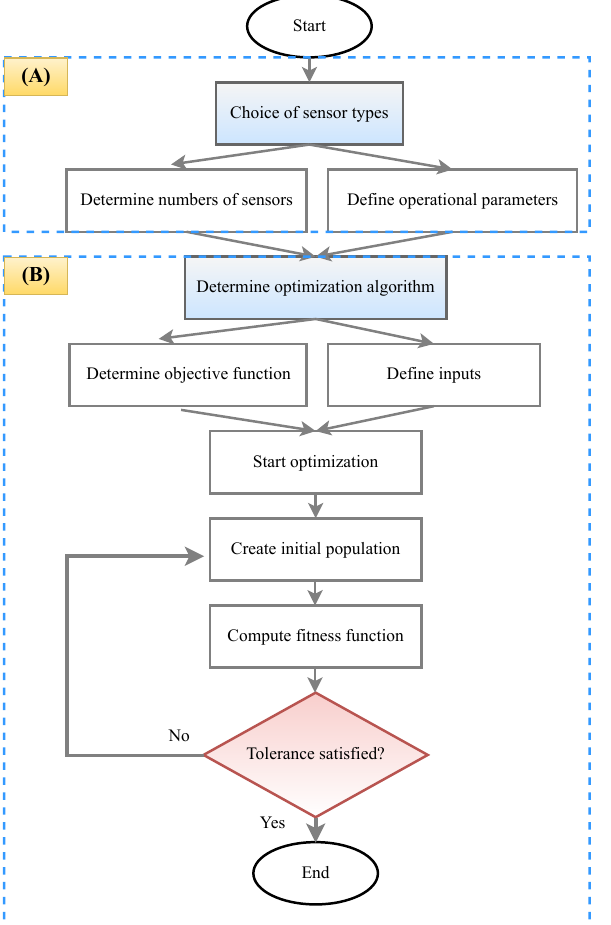
Figure 6. Flowchart for OSP (( A ): Sensor type and number, ( B ): Defining an optimization